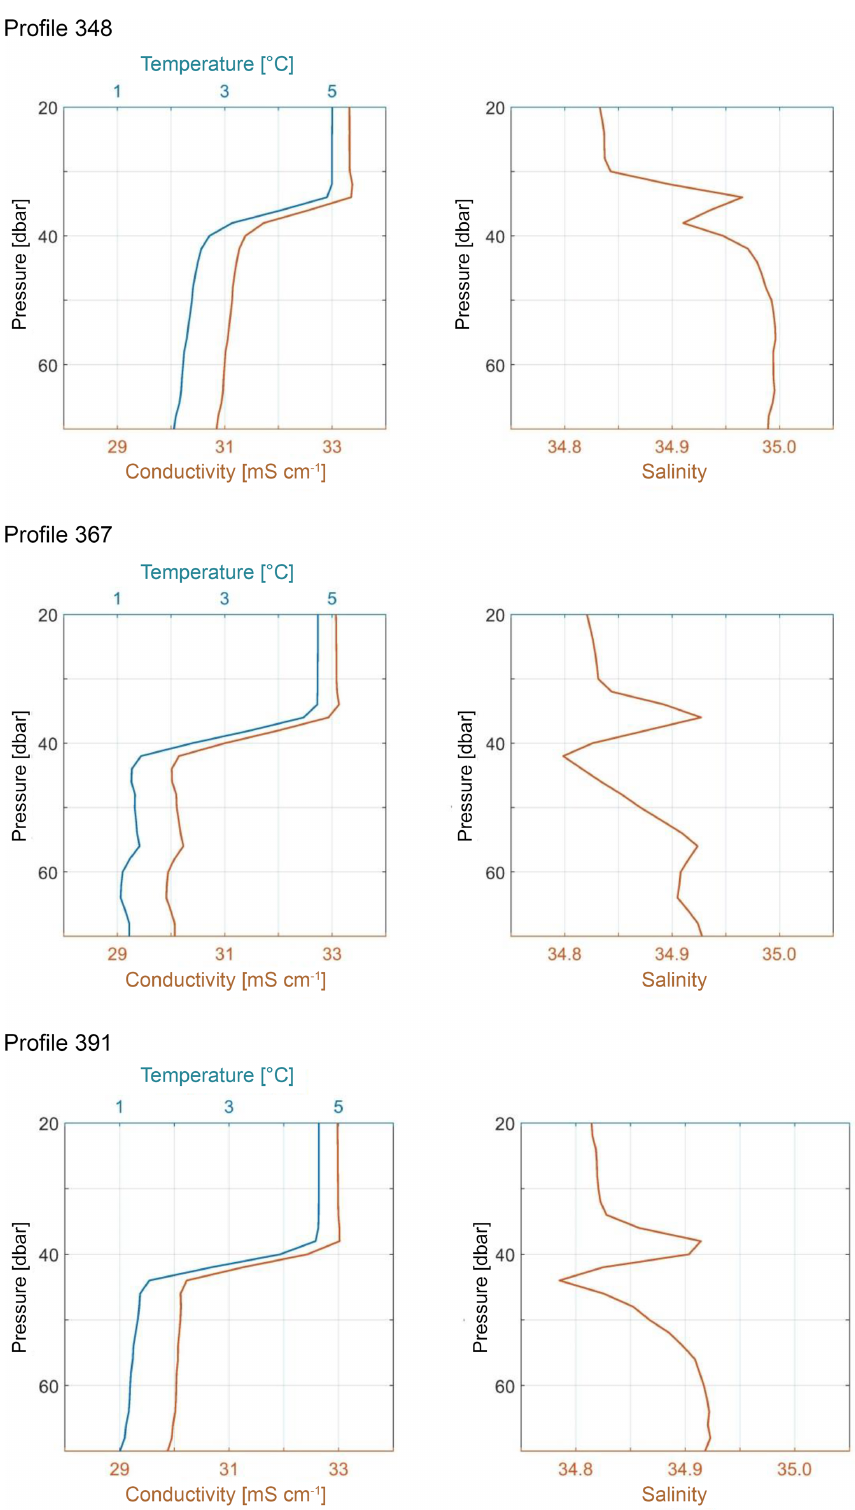
Figure 4. Exemplarily, three temperature, conductivity and salinity profiles from glider 127 during summer 2015 demonstrate how spikes in salinity show up in the depth of the highest vertical gradient between the surface layer and the water masses below. These spikes are generated by an insufficient time-lag correction (see Sect. 3.3.2 for